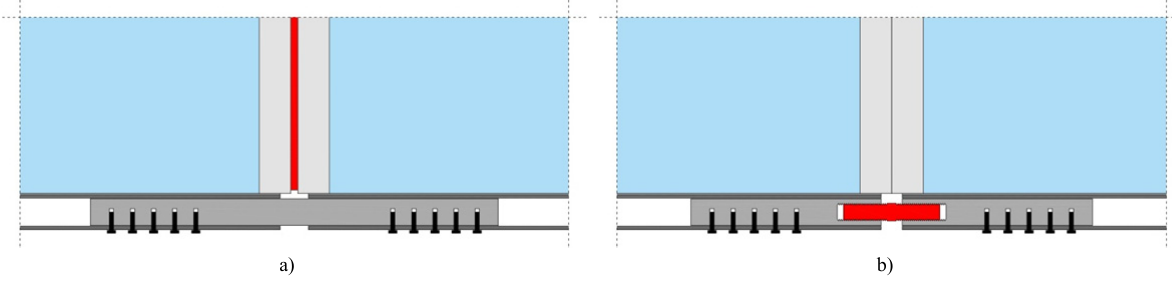
Fig. 9 Solutions to get rid of the clearance between the